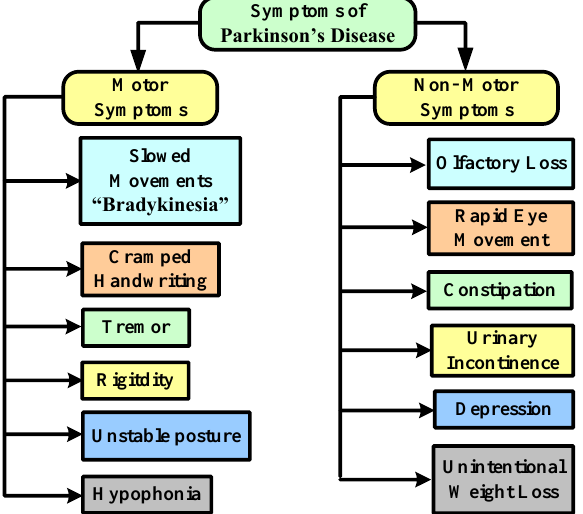
Figure 3. Symptoms of Parkinson’s disease .